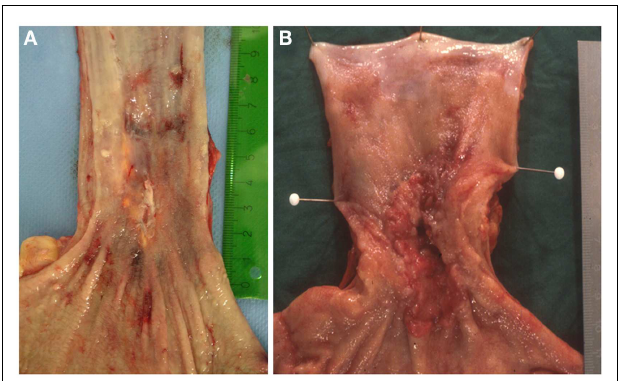
FIGURE 1 | Gross images of esophageal adenocarcinomas with (A) macroscopic significant regression and (B) no macroscopic significant regression after neoadjuvant chemotherapy .